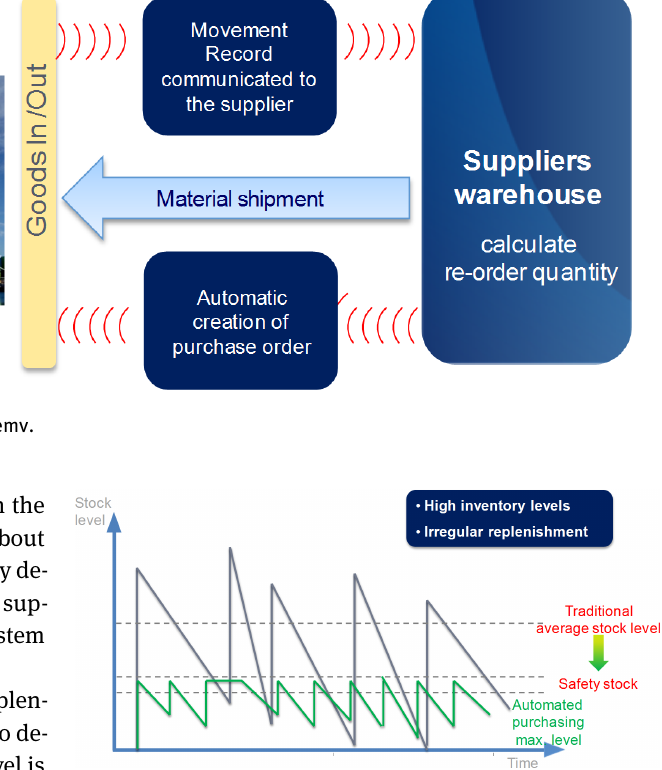
Figure 3: Comparison of traditional manual order cycles vs. an automated replenishment